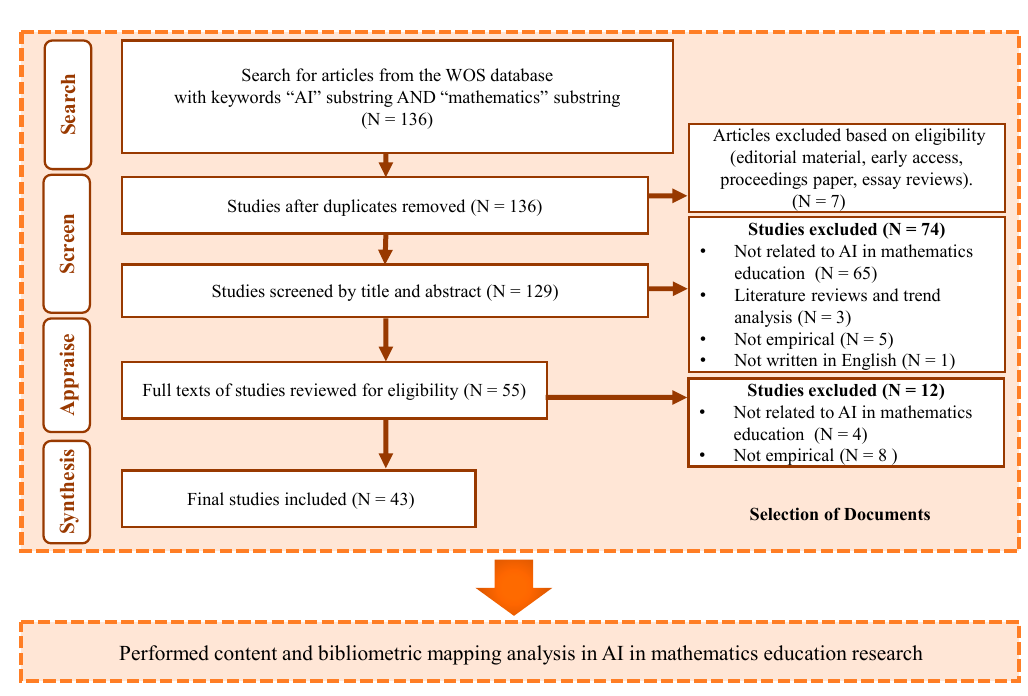
Figure 1. Article selection process for bibliometric mapping analysis and systematic review.